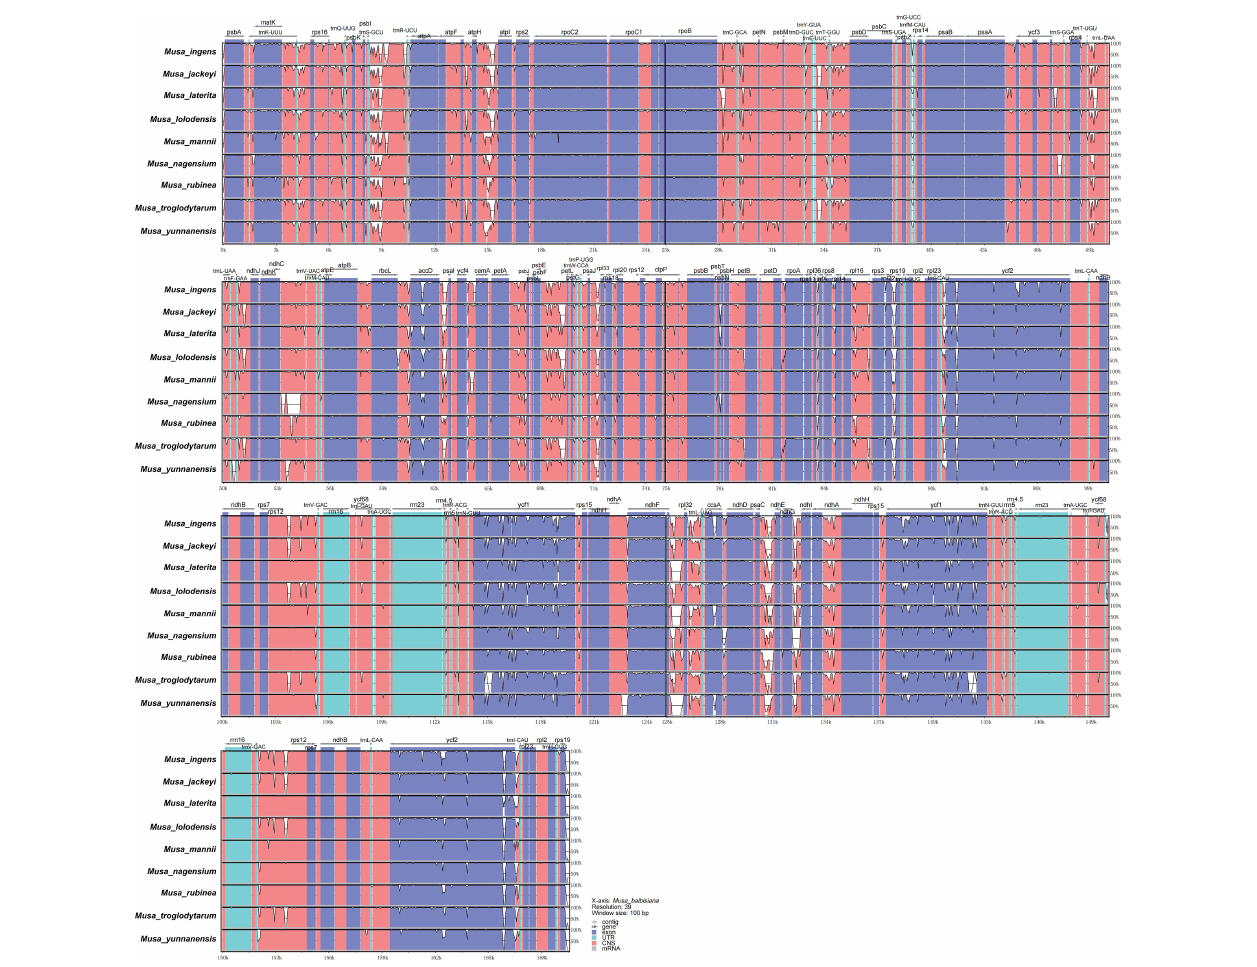
FIGURE 4 | mVISTA map of chloroplast genome of nine species of Musa . Sequence identity plot comparing the chloroplast genome of nine Musa species. The vertical scale indicates the percentage of identity, ranging from 50 to 100%. The horizontal axis indicates the coordinates within the chloroplast genome. Genome regions are color-coded as protein-coding, rRNA, tRNA, intron, and conserved non-coding sequences (CNS).